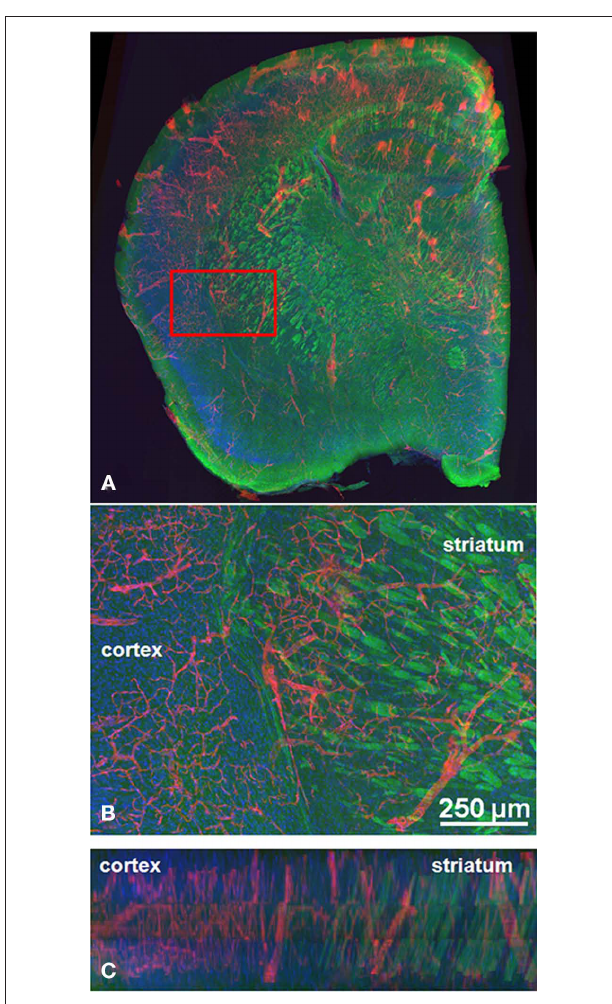
Figure 7 | Volume reconstruction evaluation. (A) A series of three coronal sections was successfully labeled with fluorescent stains, imaged, flattened, and reconstructed using Mogrifier and ir-Tweak. A higher magnification image is shown (B) where the three labels (DiI in red for the blood vessels, FluoroMyelin in green for the myelin, and TO-PRO-3 in blue for the nuclei) are more clearly discernible in the striatum and the cortex. A cross-section ( x – z plane) of this same sample region is shown in (C) . The alignment of the blood vessels (DiI) and FluoroMyelin can be seen more easily in this cross-section. These images were collected in Imaris, an application for 3D visualization and